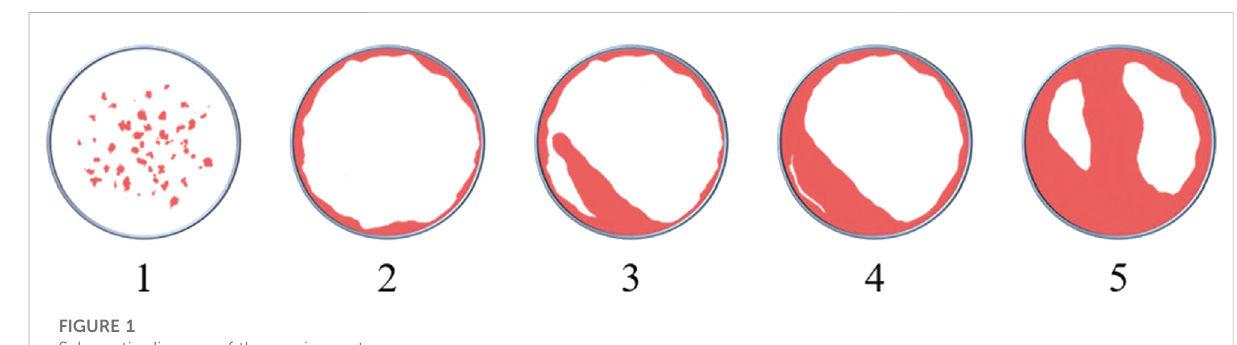
FIGURE 1 Schematic diagram of the scoring